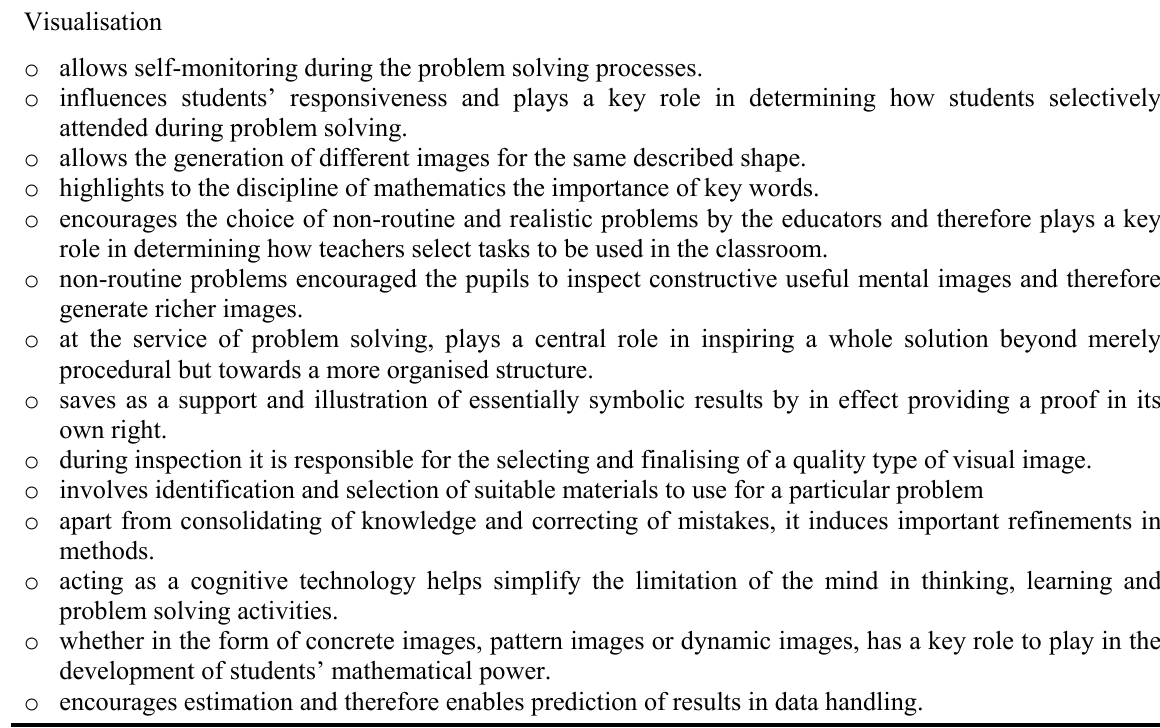
Table 4: Summary of the major findings in this study